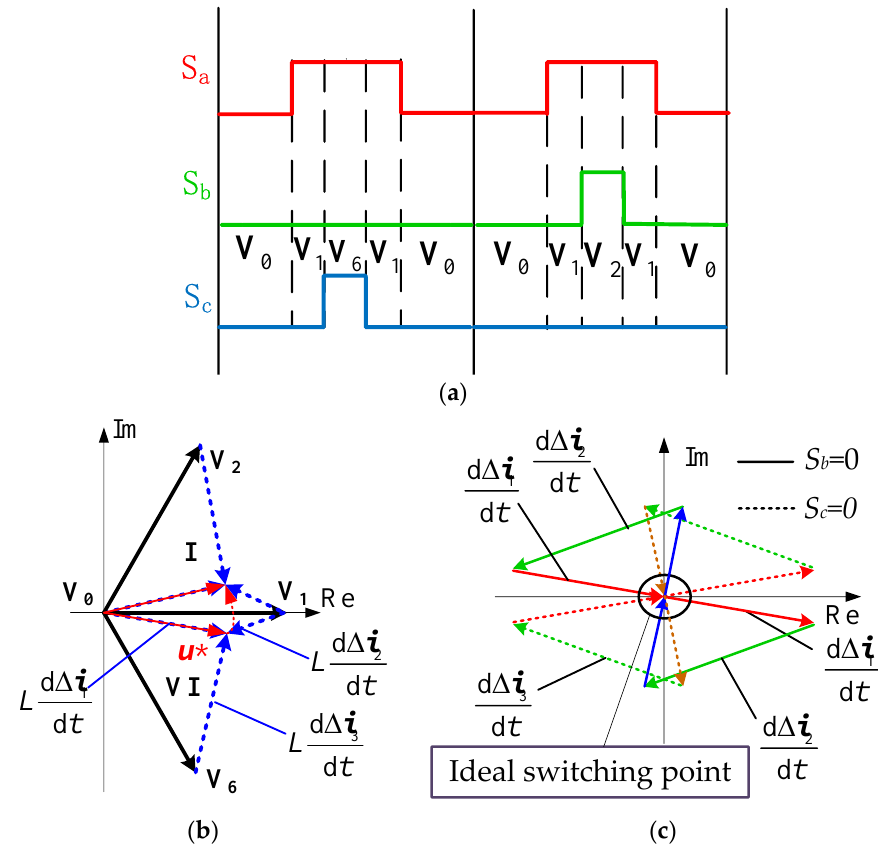
Figure 9. The ideal switching point in S-FHCC. ( a ) the operation sequence of voltage-space-vectors and three-phase switches; ( b ) the derivatives of Δ i with respect to time; ( c ) three-phase switches operation.